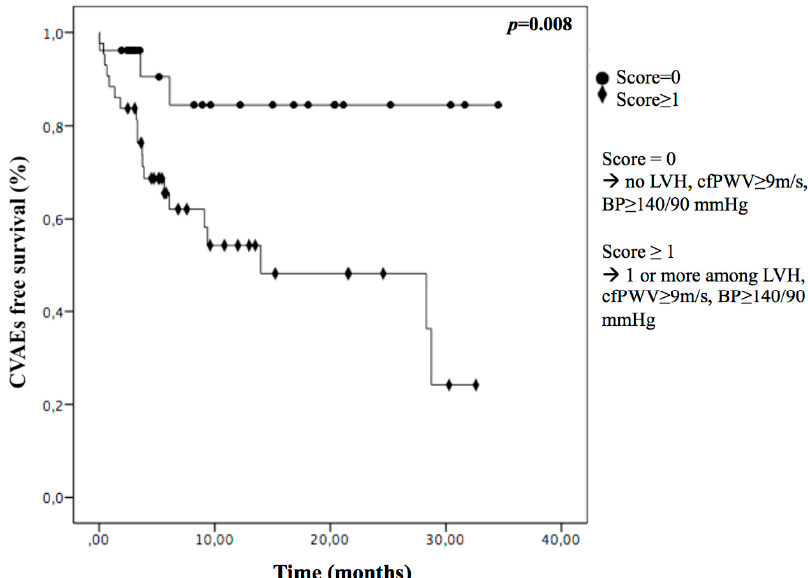
Figure 2. Kaplan Meier curves in multiple myeloma (MM) patients with (score ≥ 1) or without (score = 0) baseline uncontrolled hypertension, left ventricular hypertrophy or cf-PWV ≥ 9 m/s. LVH = left ventricular hypertrophy; cf-PWV = pulse wave velocity; BP = blood pressure.